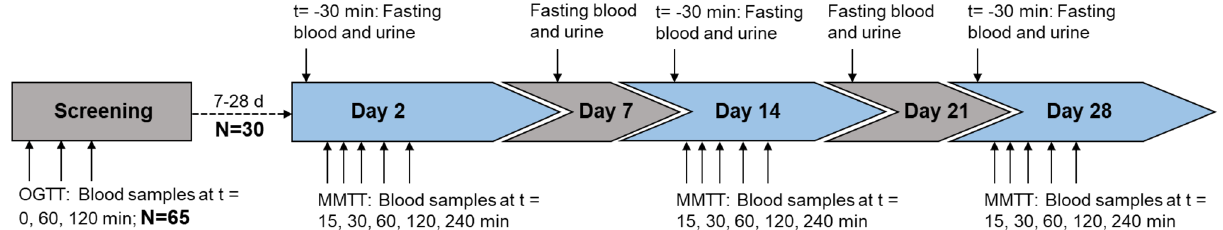
Figure 1. Graphical study design. Grey: ambulatory visits. Blue: in-house study days with participants staying the night before the study day at the study center.